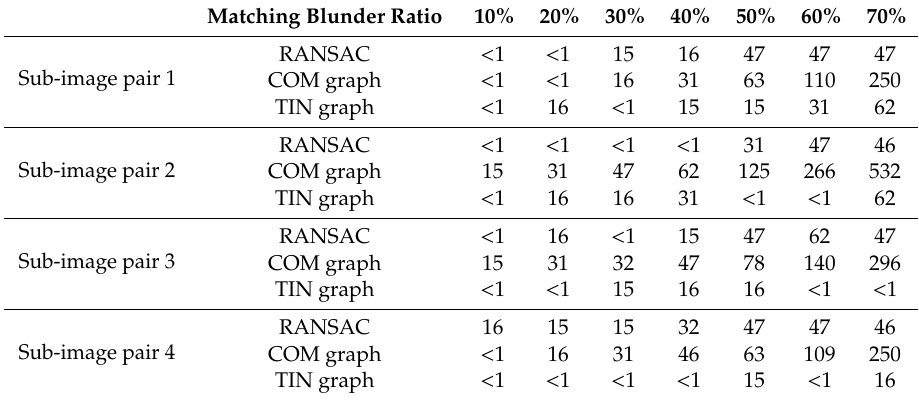
Table1. Experimentalresultsofcomputationtime t (ms, t within1msisnotrecorded). RANSAC—classical random sample